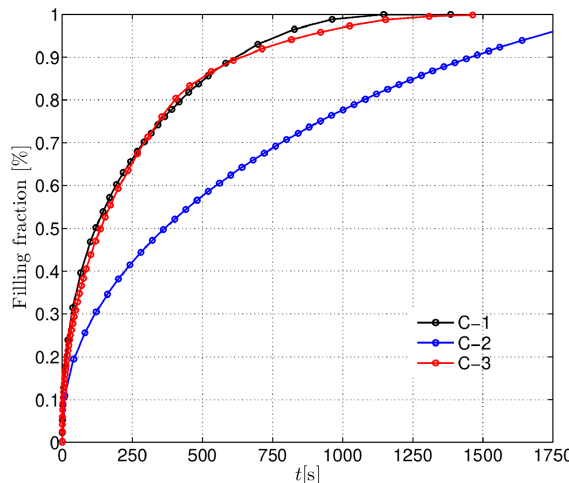
Figure 9. Filling fraction as function of time for the different inlet gate configurations.